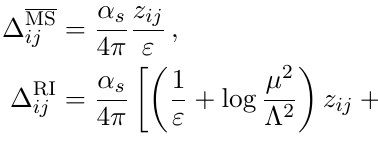
Figure 6 . Quark-gluon three-point and four-point functions at one-loop, with the insertion of the gCEDM operator O (1) denoted by a square. Only one possible insertion of the gCEDM is shown. 6 The hatched blobs denote one-loop subdiagrams with a gCEDM insertion, while the gray blobs denote QCD one-loop